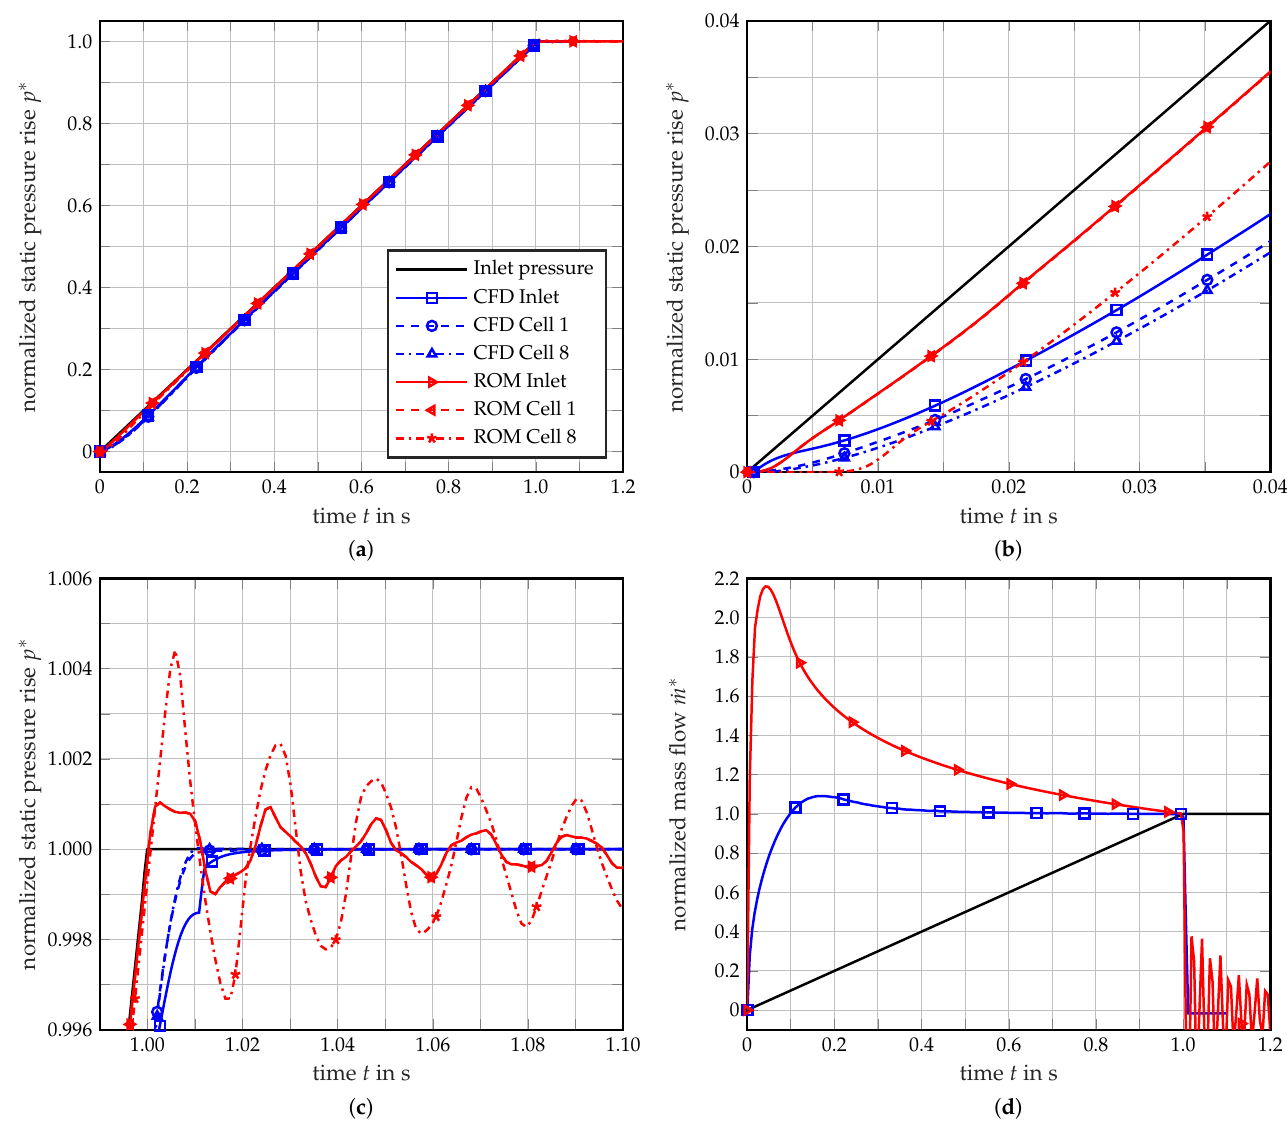
Figure 8. Comparison of CFD and reduced-order model (ROM) filling processes: ( a ) Normalized pressure rise p ∗ during overall filling process. ( b ) Start of filling process. ( c ) End of filling process. ( d ) Normalized mass flow ˙ m ∗ at